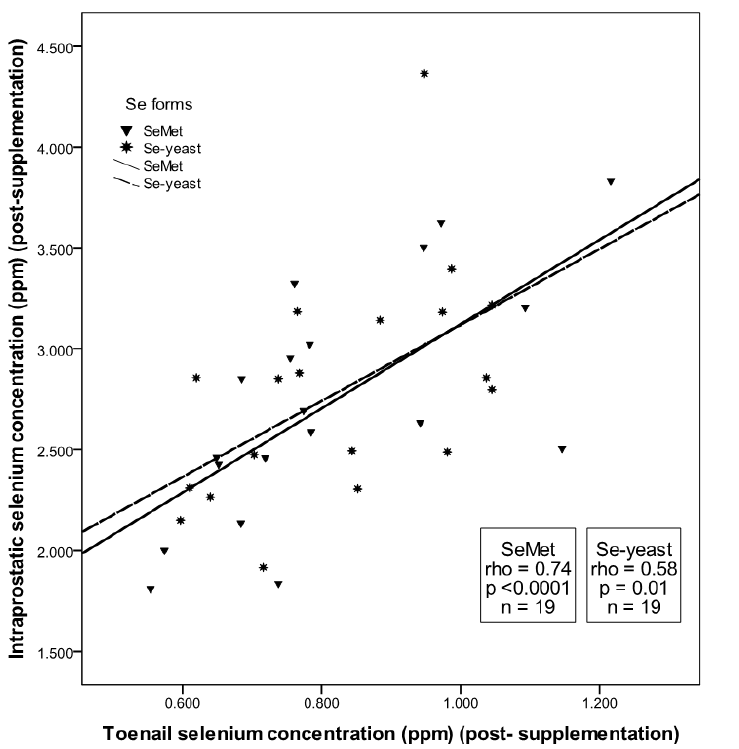
Figure 3. Correlation between toenail and intraprostatic selenium concentration after seven months of supplementation with selenomethionine (SeMet) or selenized yeast